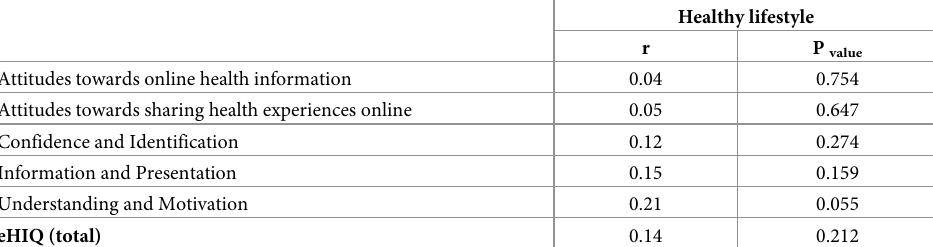
Table 5. Correlations of online health information-seeking subscales with healthy